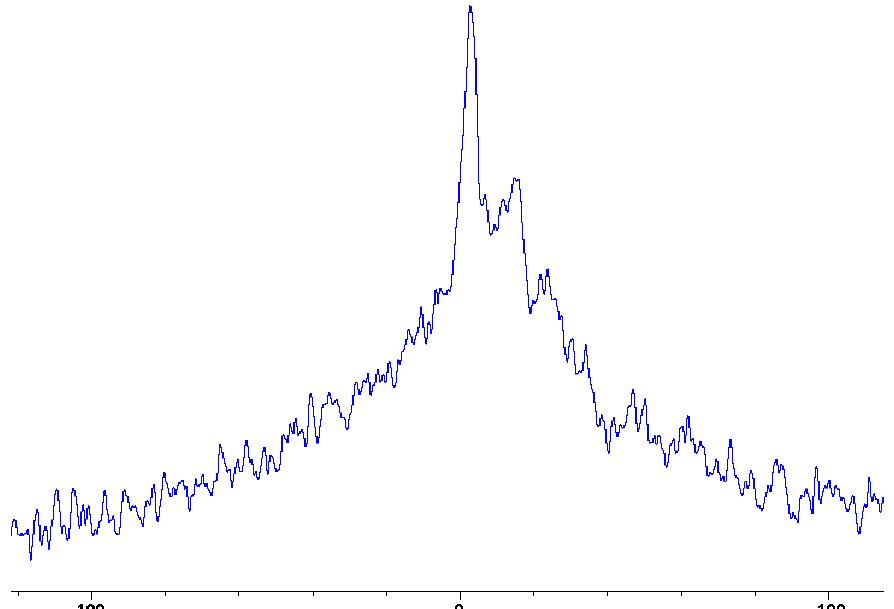
Figure 6. Solid-state 31 P-NMR spectrum of char obtained from fish gelatin + triethylphosphite (TEPi) (the abscissa denotes the chemical shift values, δ , in ppm and the ordinate corresponds to the signal intensity in arbitrary units).